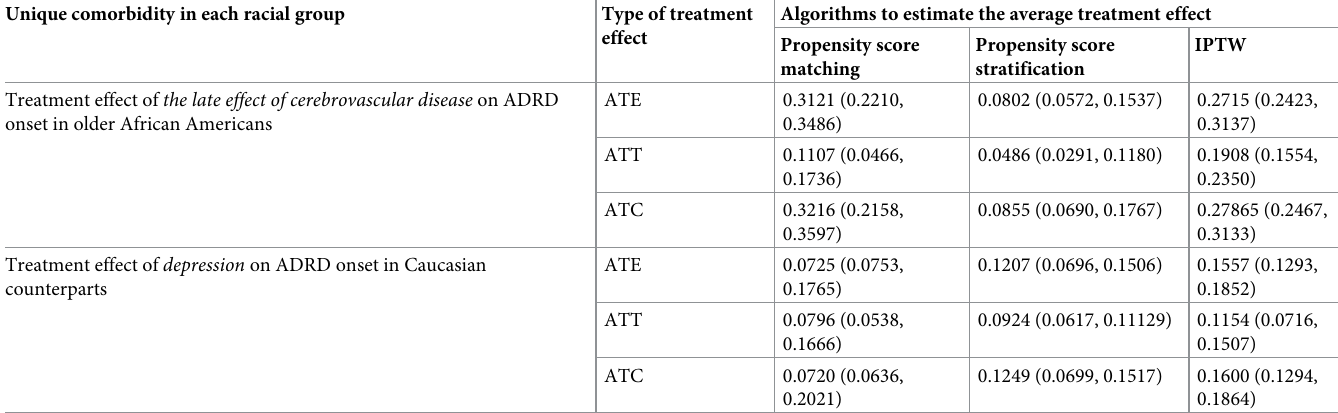
Table 4. Treatment effect of comorbidity on ADRD onset (95% confidence interval). ATE = Average treatment effect, ATT = Average treatment effect among treated (ATE among the subjects with the comorbidity), ATC = Average treatment effect among controls (ATE among the subjects without the comorbidity). IPTW = Inverse probability of treatment